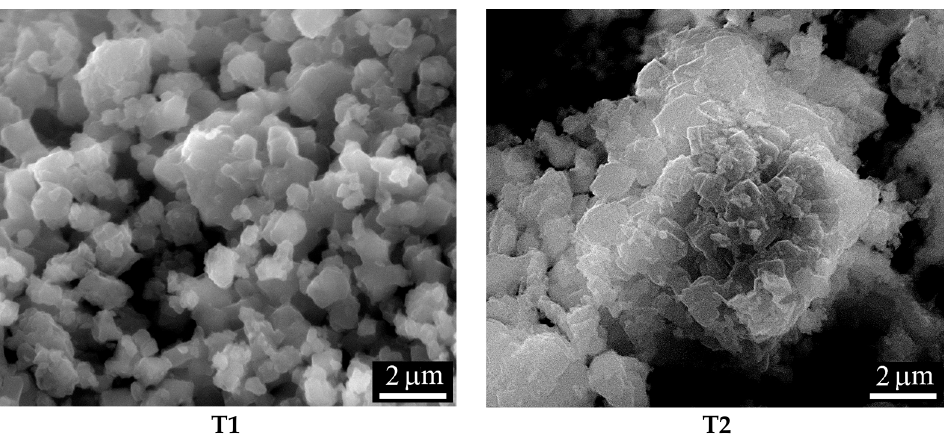
Figure 14. SEM images of the synthesized powders.